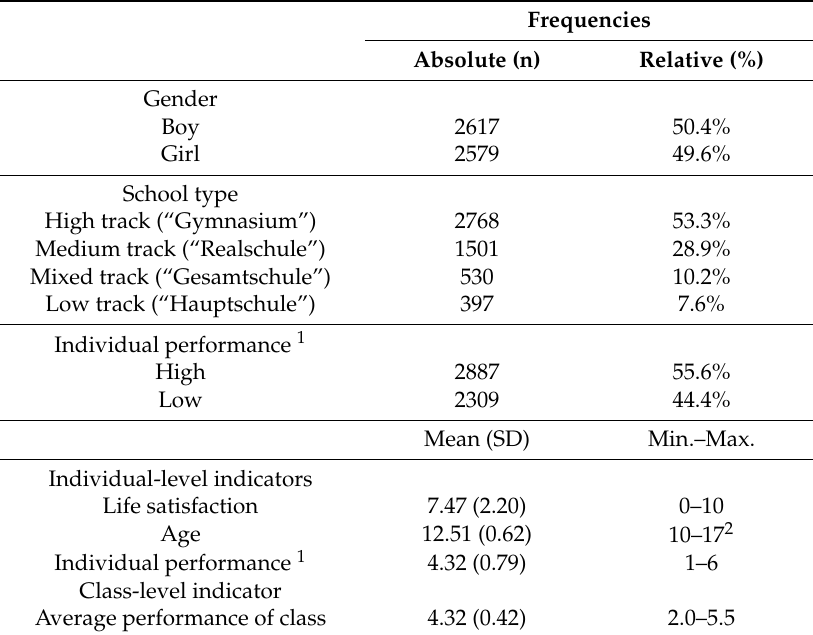
Table 1. Sample description (NEPS SC3, n = 5196